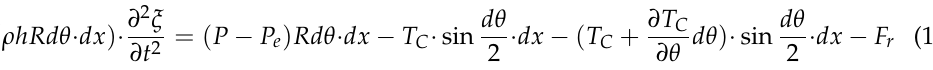
where P represents the internal pressure of the blood vessel wall, P e represents the external pressure of the blood vessel wall and by substituting Formulas (7) and (9) into Formula